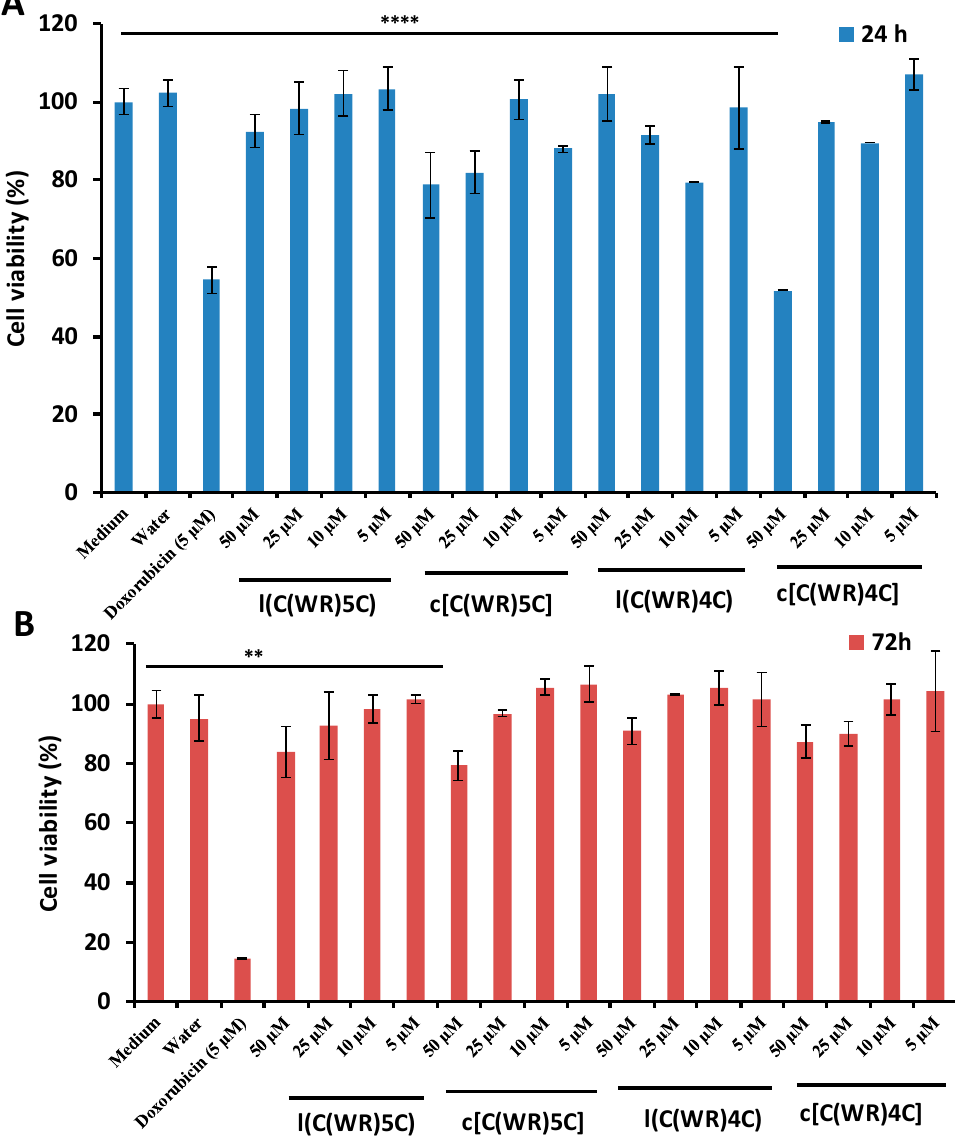
Figure 4. MTS assay of peptides (5–50 µM) on CRL-1739 cell lines: ( A ) 24 h incubation and ( B ) 72 h incubation ( n = 3) (if p < 0.05 then *, if p < 0.01 then **, if p < 0.001 then ***, if p < 0.0001 then ****). Error bars are SD.